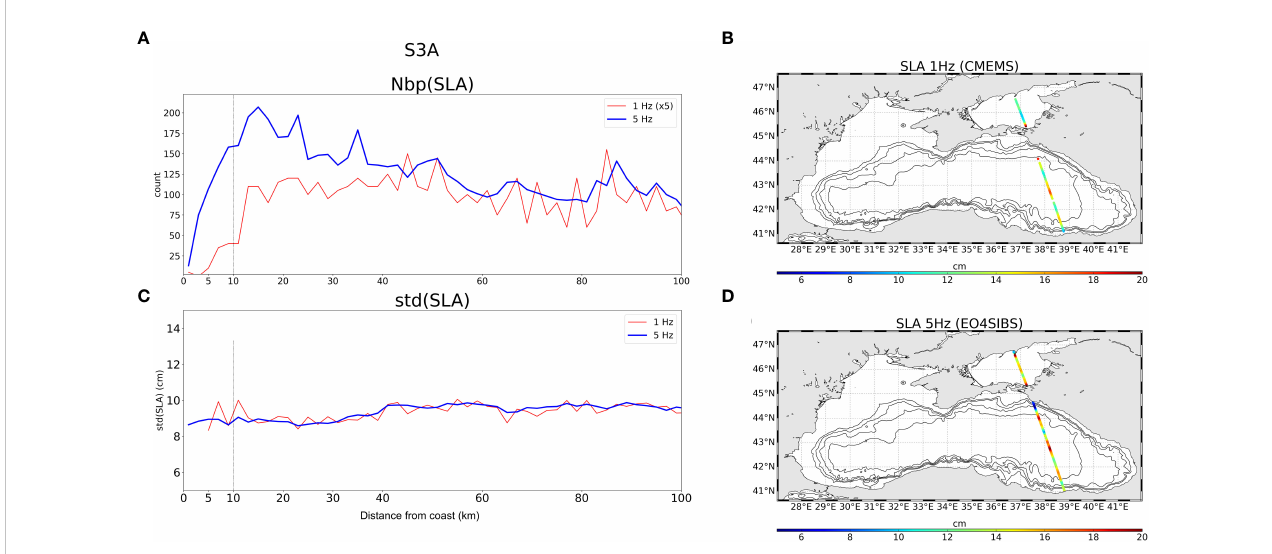
FIGURE 2 Left: Number of valid measurements (A) and mean SLA variance (C) as a function of the distance to the coast. Statistics computed on S3A measurements from 1Hz (red line) and 5Hz (blue line) products. Only measurement points with a minimal sampling rate of 80% compared to the maximal number of expected cycles are considered. The number of valid 5Hz measurements is divided by a factor 5 before comparison with the 1Hz product. Statistics computed over the Black Sea. Right: Example of SLA along a S3A track (date 2017/07/03) for 1Hz CMEMS product (B) and EO4SIBS 5Hz product (D)